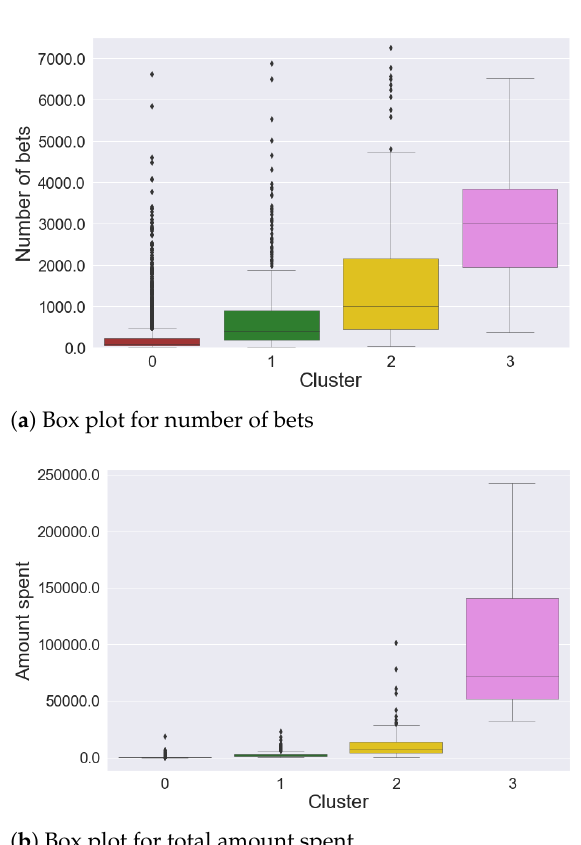
Figure 13. Elbow method plot on black jack data using the time series k -means. Figure 14 shows the analogous box plots presented in the previous section, for the results related to black jack.